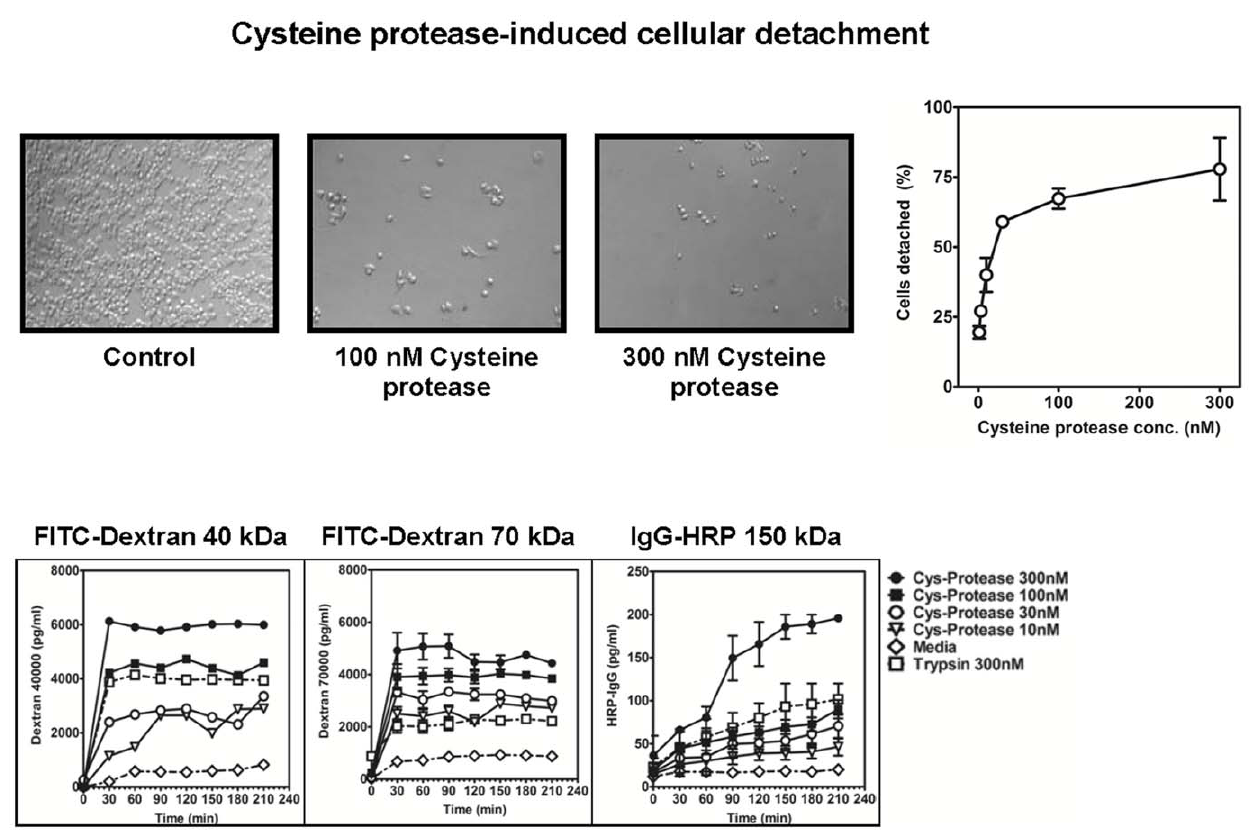
Figure 6. Concentration-dependent detachment of airway epithelial cells by pollen cysteine protease. Confluent monolayers of A549 epithelial cells were treated with Bermuda pollen coat cysteine protease for a 3-hour period (upper left panels) . After light microscopic observation, cell detachment was assessed as described in Materials and Methods. Light-microscopic photos of the average cell density of the epithelial cell exposed to the serum-free medium F-12 (0 nM) and to serum-free media containing (300 nM) cysteine protease are shown. After 1 hour of incubation, the cells were analyzed by light-microscopic imaging. Microscopic images were taken at 6 10 magnification. Bar=25 um. Each image is representative of three individual wells. Following microscopy, the percentage of detached cells was determined and is expressed as a percentage relative to detachment observed in untreated control cells (upper right panel). Error bars represent means 6 SD of four independent experiments. Pollen coat cysteine protease increases paracellular permeability of A549 epithelial cells (lower panel). The apical surface of the confluent A549 airway epithelial monolayers were left untreated (0) or treated with a solution of 1, 3, 10, 30, 100 or 300 nM purified cysteine protease for the indicated time. Paracellular permeability of epithelial cells by measurement of the apical-to-basolateral flux of FITC-dextran 40 kDa, FITC-dextran 70 kDa and IgG-HRP 150 kDa as described in Materials and Methods are shown.